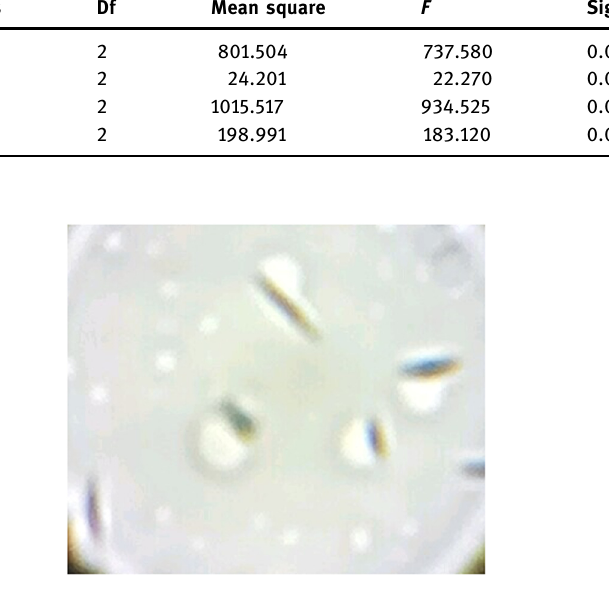
Table 4: Orthogonal ANOVA of the EE of GB in the niosomal complex suspension Type III sum of squares